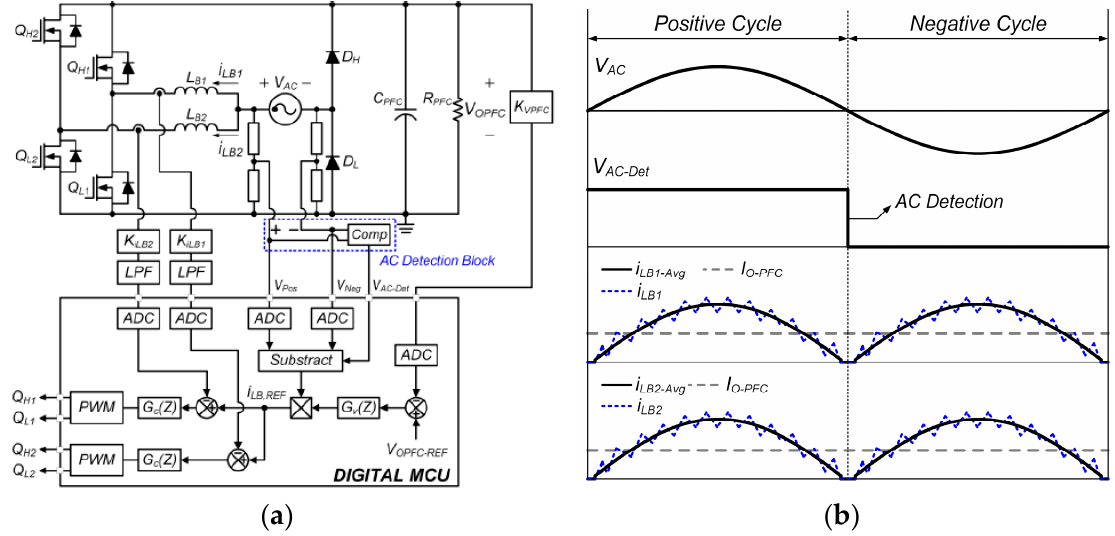
Figure 1. Conventional interleaved totem-pole bridgeless boost power factor correction (PFC) converter. ( a ) Circuit diagram with control blocks. ( b ) Key waveforms.